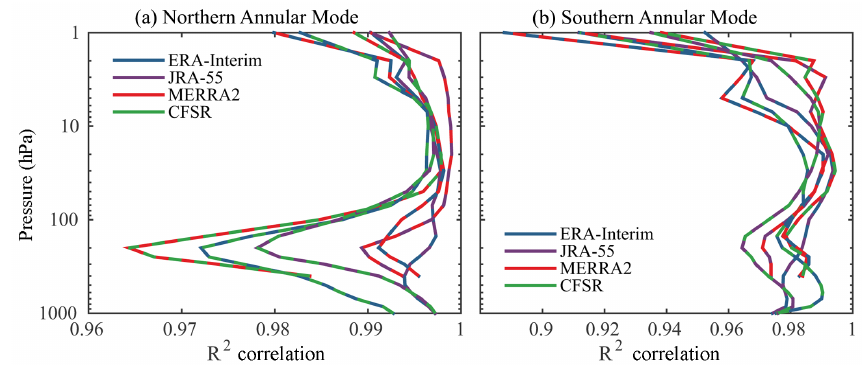
Figure 3. Consistency of (a) the Northern and (b) Southern Annular Mode indices in the modern reanalyses over the period 1981–2010, quantified by the pairwise correlation coefficient ( R 2 ) between the annular mode indices computed from ERA-Interim, JRA-55, MERRA2, and CFSR, plotted as a function of height. The dashed colors indicate the respective indices that are being compared; for example, the green– red dashed lines indicate the square correlation between MERRA2 and CFSR. The square of the correlation coefficient, R 2 , indicates the fraction of variance shared between two time series. Hence, one may conclude that the NAM indices in MERRA2 and CFSR share greater than 96% of the variance at all levels.